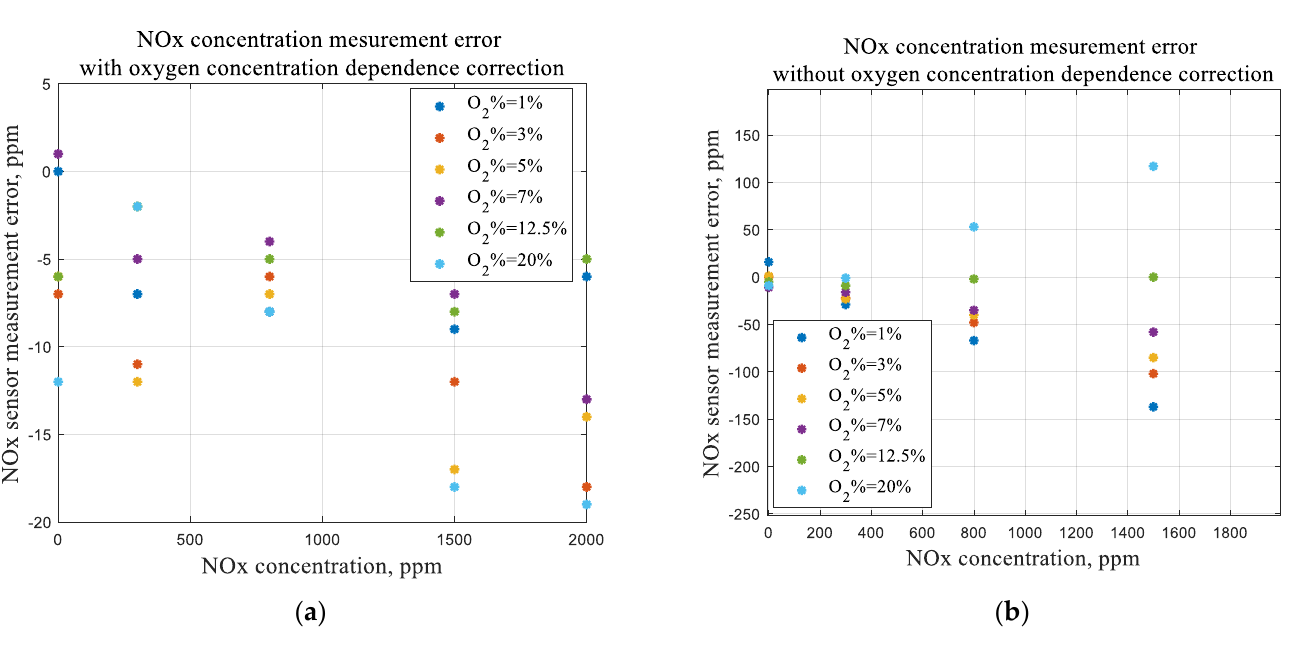
Figure 18. The calibration results for oxygen concentration dependence.